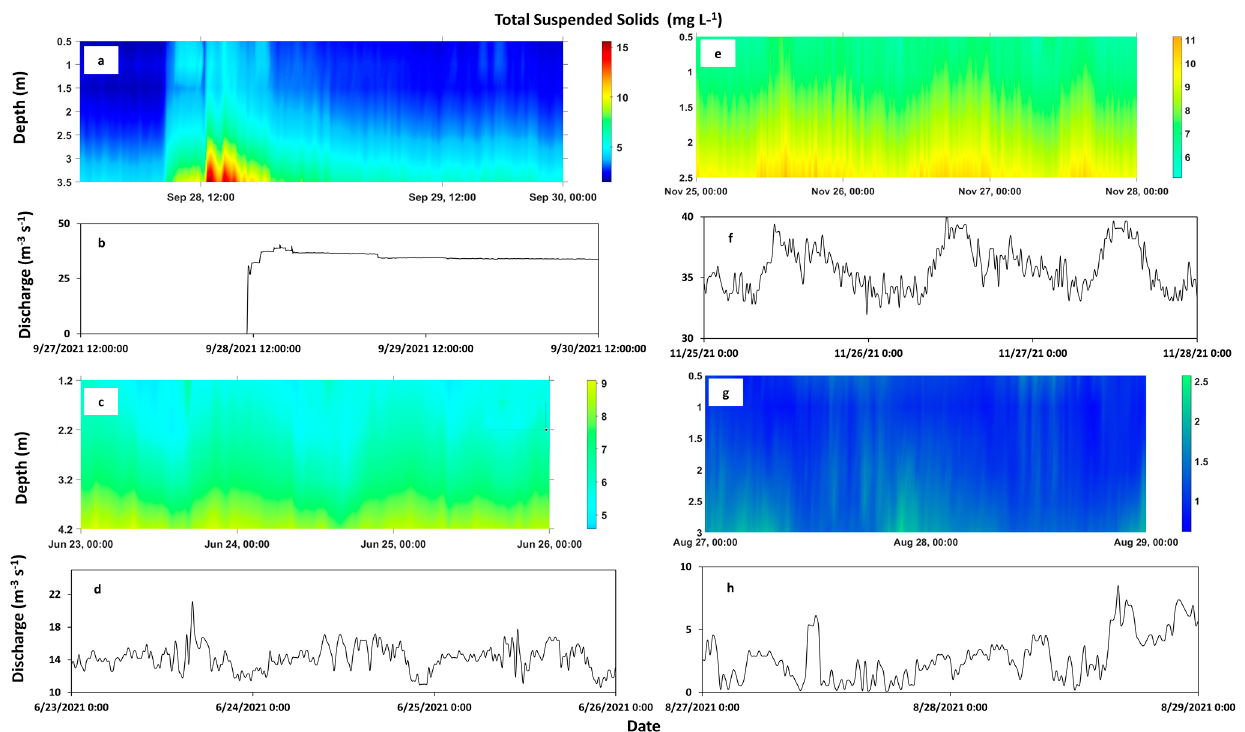
Figure 6. Vertical distribution of estimates of total suspended sediments (TSS) in the water column and the corresponding discharges at the upstream, UP ( a , b ), downstream in June, DS − Jun ( c , d ), downstream in December, DS − Dec ( e , f ), and interior, INT ( g , h ), sites in the L − 29 Canal in 2021. The depths are the sizes of the user-determined bins of the ADCP. The uncorrected echo intensity (EI) from the acoustic Doppler current profiler (ADCP) was used to generate the TSS estimates via calibration curves. The calibration curve developed for DS − Jun was also used to estimate TSS for DS − Dec. For clarity, these plots are portions of the deployment time series.